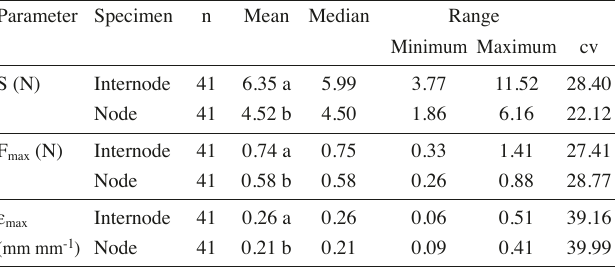
Tab. 2: Mean, median, minimum, maximum and coefficient of variation of stiffness (S), maximum force (F max ) and maximum strains ( ε max ) of internodes and nodes from position 2 and 3 of Chara corallina . Means of internodes and nodes are significantly different, P <